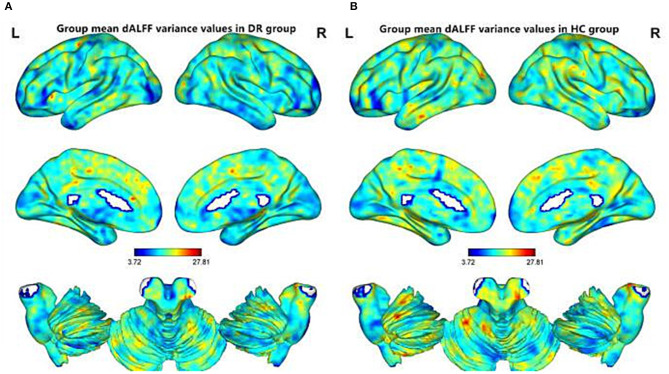
Spatial patterns of dALFF variance were observed at the group level in DR and HC groups. Within group mean dALFF variance maps within the DR (A) and HC (B). dALFF, dynamic amplitude of low-frequency fluctuation; DR, Diabetic Retinopathy; HC, Health Controls; L, left; R, right.